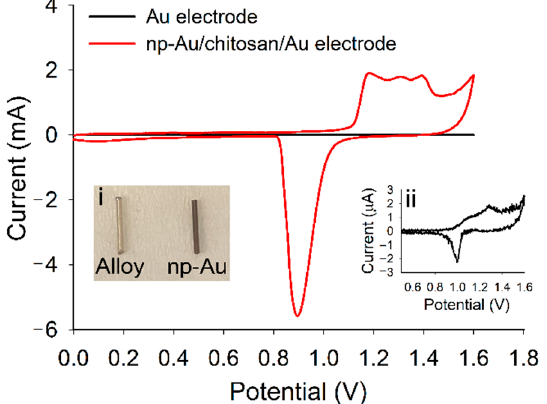
Figure 1. Cyclic voltammogram (CV) of the Au electrode (black) and np-Au millirod placed on the Au electrode (red); insets (i) is a photographic image of alloy and np-Au millirod (length = 5 mm) and (ii) is the magnified CV of the Au electrode.